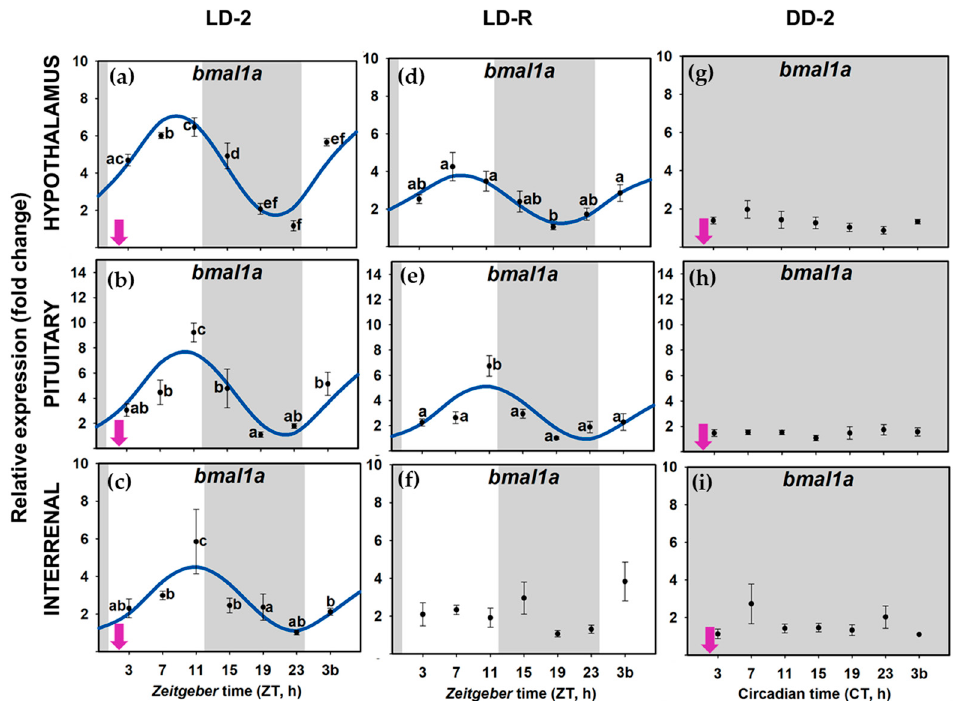
Figure 7. Relative expression of bmal1a in hypothalamus ( a , d , g ), pituitary ( b , e , h ) and interrenal tissue ( c , f , i ) of goldfish. Data are expressed as mean ± standard error ( n = 8). Grey areas indicate the darkness period, and arrows point to the feeding time when it was scheduled (ZT 2). Different letters show significant differences among groups (ANOVA and SNK test). The curves show sinusoidal periodic functions obtained by cosinor analysis when it was significant (noise/signal < 0.3).